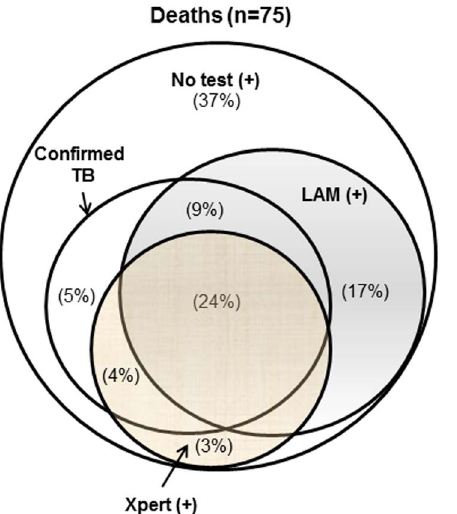
Figure 2. Venn diagram showing the proportions of patients confirmed dead at 2 months (n=75) who had positive sputum and/or blood cultures (‘‘confirmed TB’’), Xpert MTB/RIF positive, and Determine TB LAM LFA positive. Mutually exclusive proportions of patients are shown in each compartment. 17% of the patients who died were LAM positive, but were neither Xpert nor culture confirmed. 24% of the patients who died were positive by all assays.